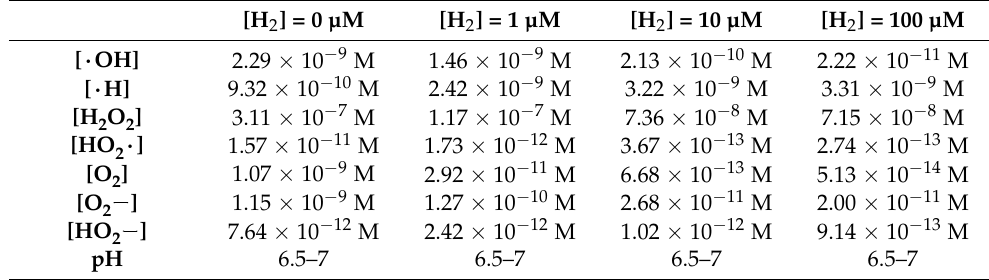
Figure 9. H 2 O 2 and O 2 concentration profiles as a function of exposure time at pH 60 ( a ) 6.5, ( b ) 7, and ( c ) 7.5 with different H 2 concentrations (0–100 µM). Table 5. Concentrations of main species after 1 year of constant radiation at pH 60 6.5 with different [H 2 ] 0